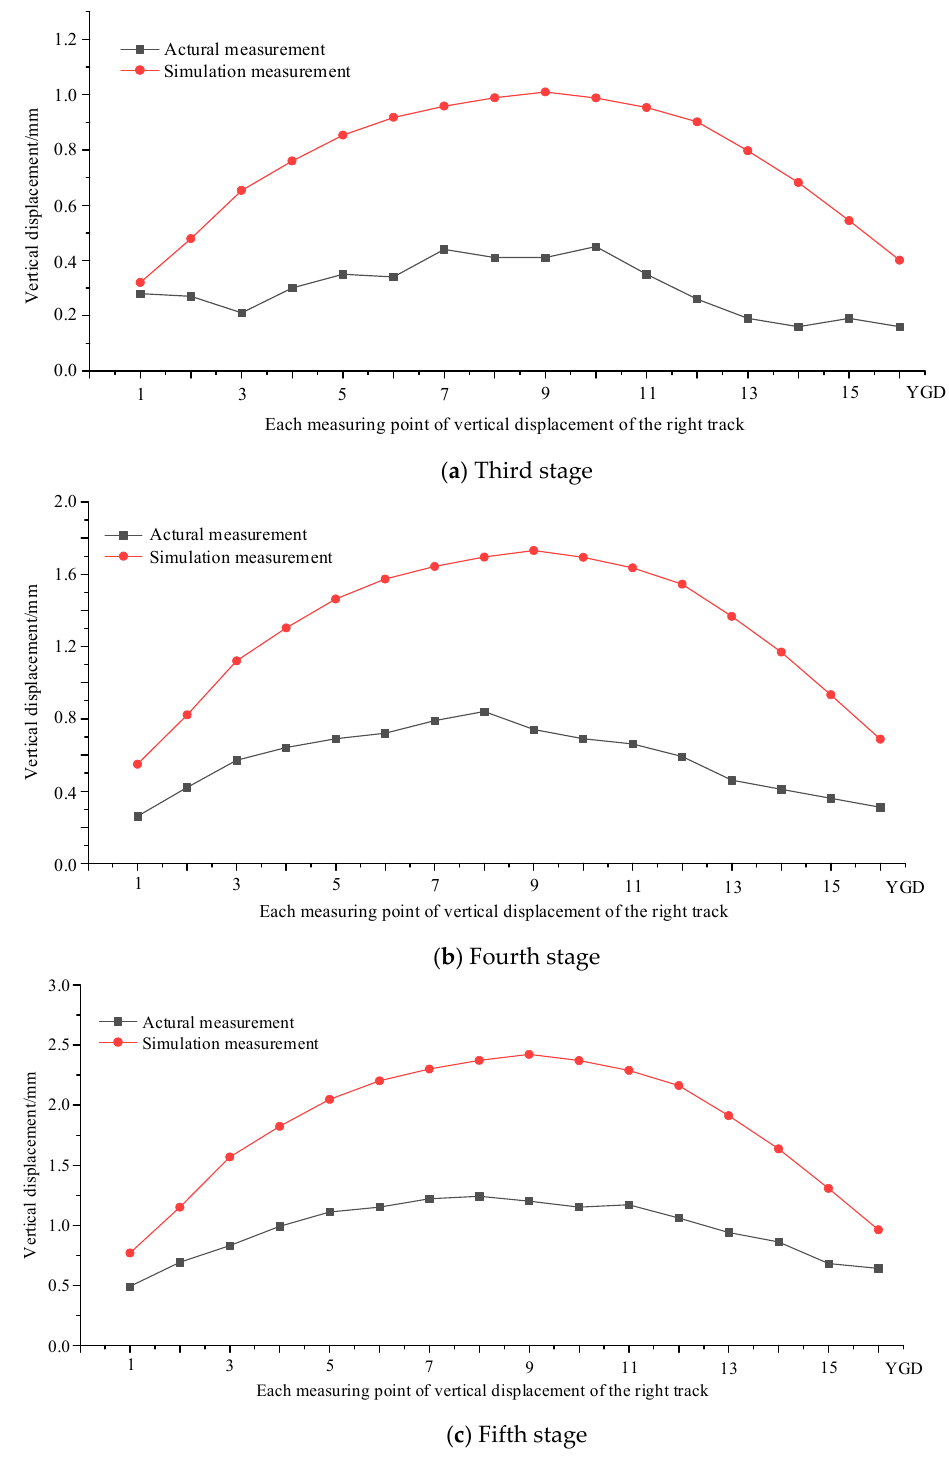
Figure 24. Comparison of the simulation and actual measurement of vertical displacement of each measuring point of the track.